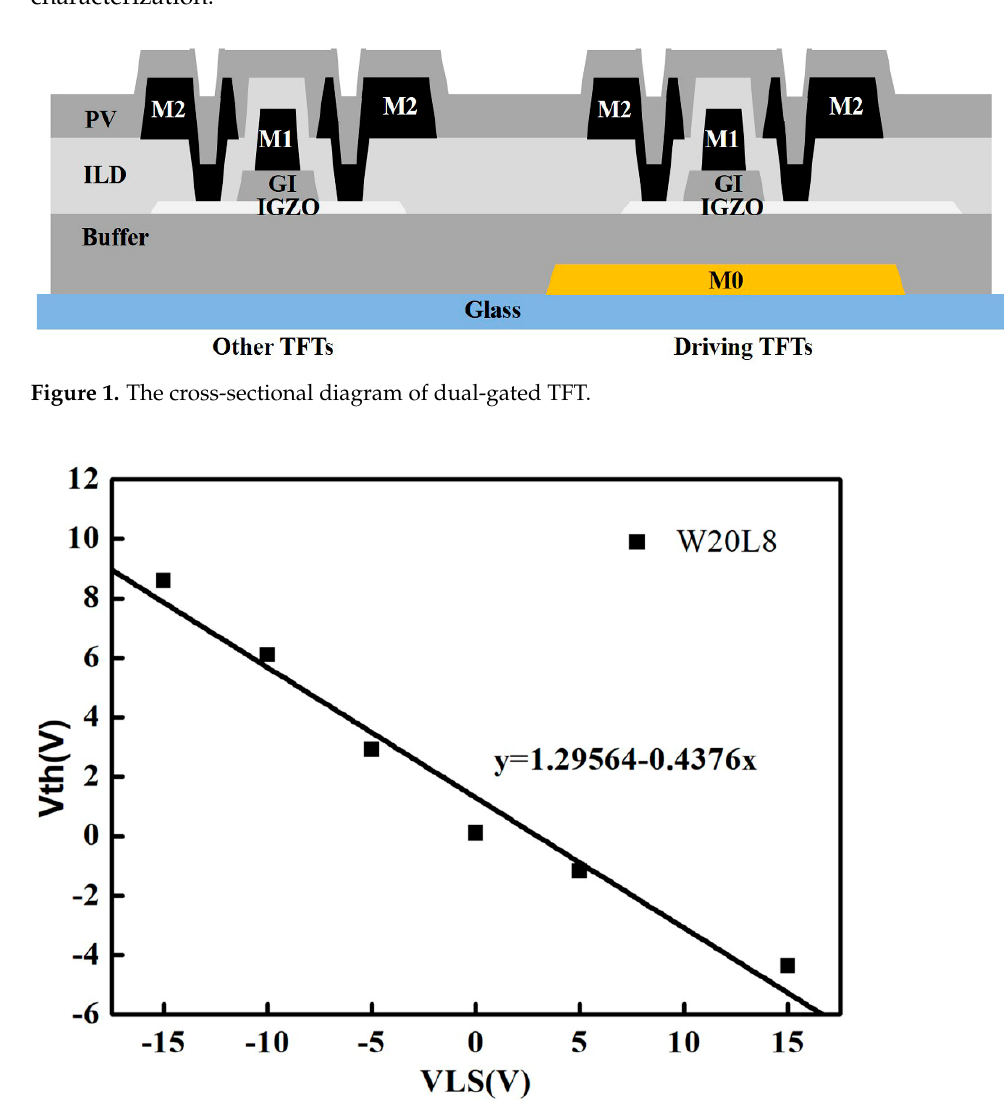
Figure 2. The effect of M0 voltage to Vth in dual-gate TFTs.